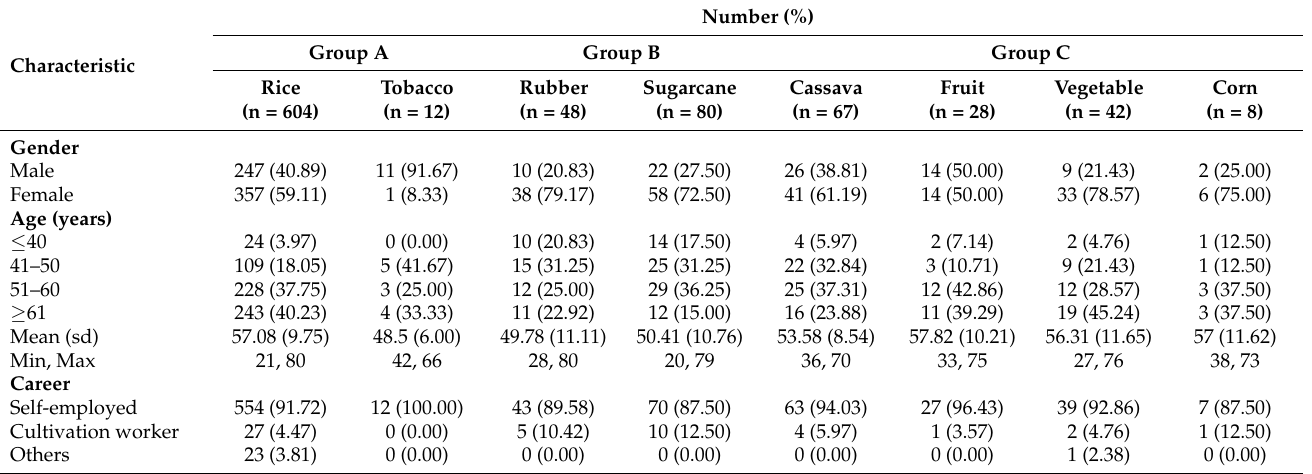
Table 1. Number (%) of participants classified according to characteristics and grouped according to cultivation type (n =